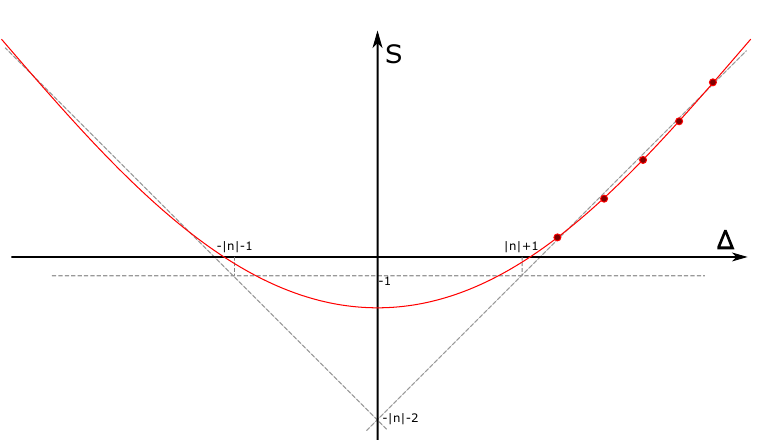
Figure 1 . Trajectory of the length-2 operator for conformal spin n = S 2 as a function of the full dimension (cid:1). The dots correspond to local operators tr ZD S restricted to be